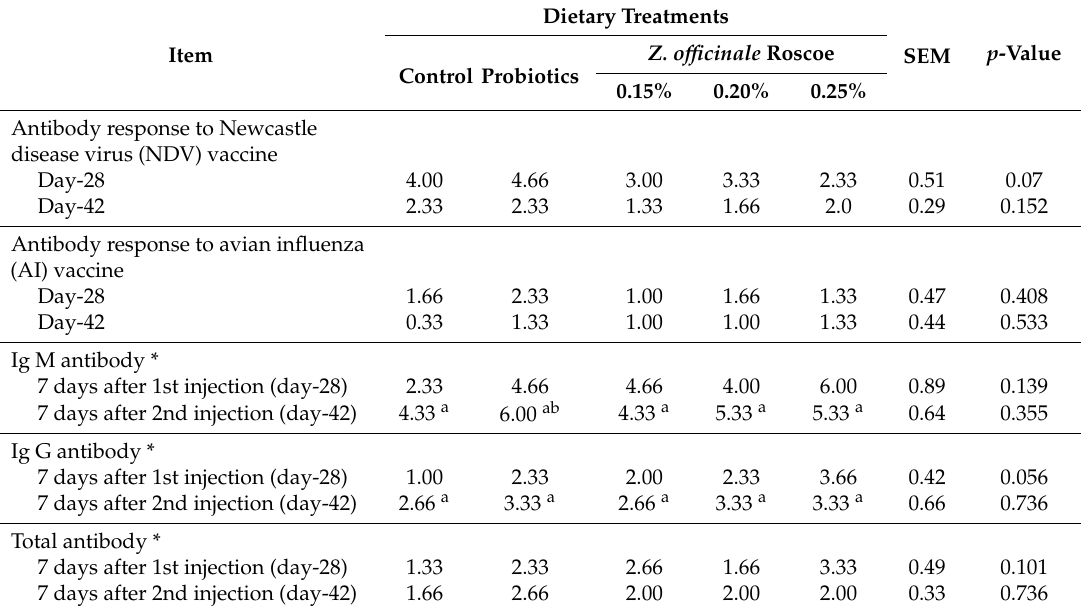
Table 5. Effect of experimental diets on immunity parameters of broilers (log 2 ).